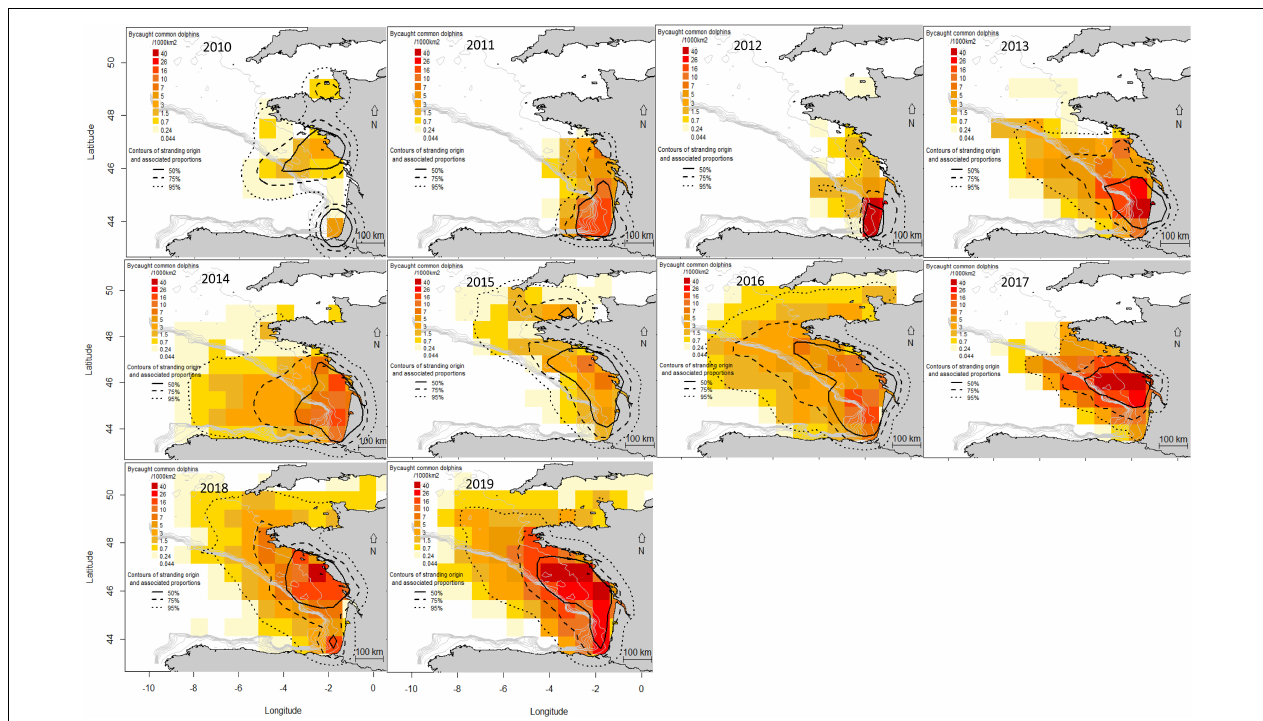
FIGURE 5 | Origin of stranded common dolphins with bycatch evidence. Densities are presented in dead dolphins/1,000 km 2 . The areas defined by solid lines included 50% of stranded dolphins, dashed lines included 75% of stranded dolphins and dotted lines 95% of stranded